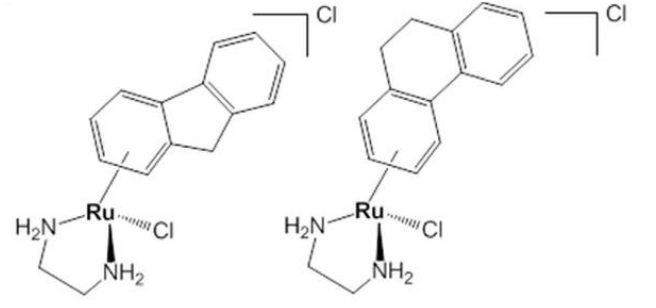
Figure 12. Chemical structures of AH54 (left) and AH63 (right) [83].